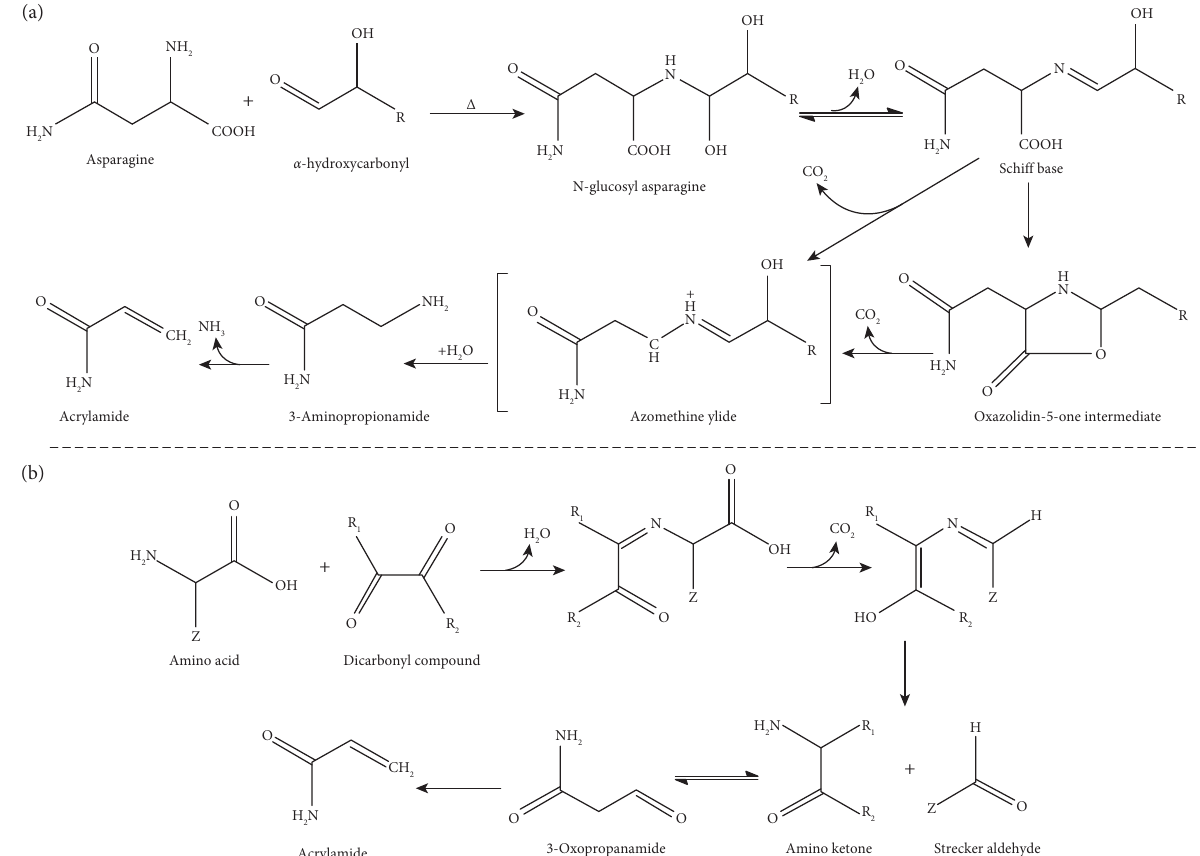
Figure 2: Mechanism of AA formation in heated foods. (a) Principle of decarboxylation of Schif base to form AA. (b) Te principle that dicarbonyl compounds are degraded by Strecker to form